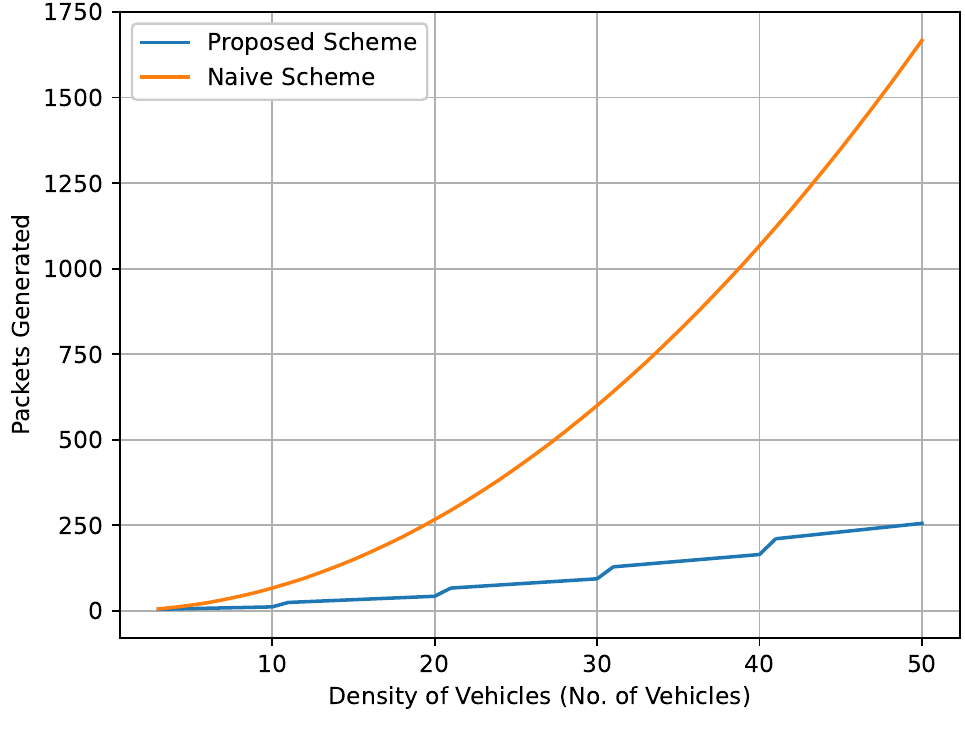
Figure 10. Total number of data packets broadcast with respect to the increasing number of